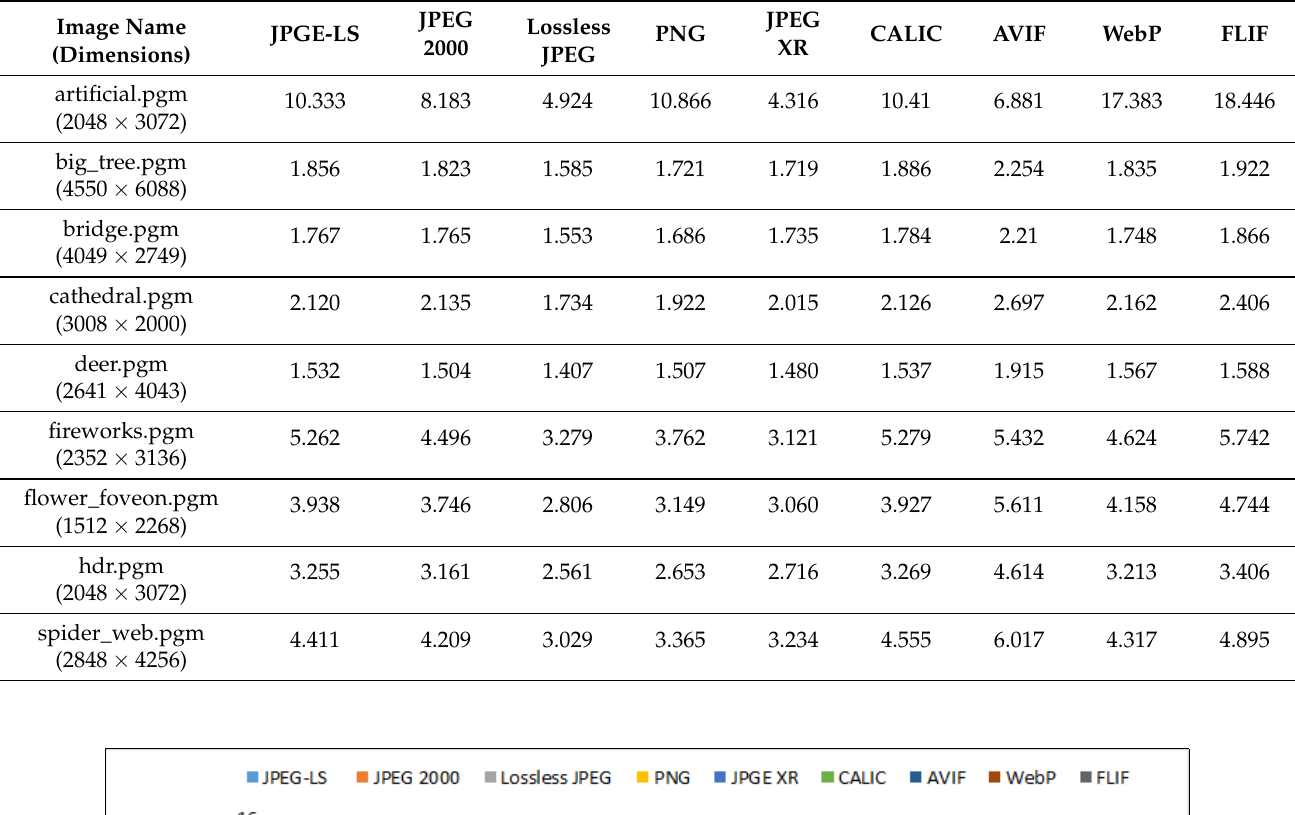
Table 6. Comparison of compression ratios for 8-bit RGB images.